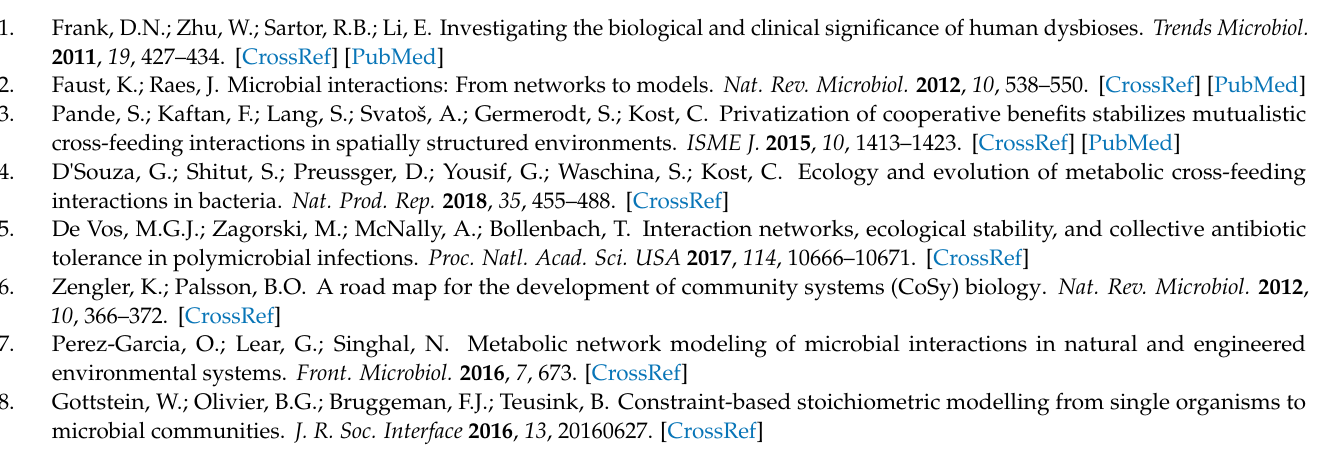
R.: representative. Table S2: Table containing a second selection of genomes for the in silico UTI community. The information was retrieved in July 2021. Genomes were selected in a similar manner with the Supplementary Table S1. Table S3: Complementarity indices. All of them normalized by pathway length. D is the number of KO’s present in the donor d; A is the equivalent for the acceptor a. Table S4: Competition indices. All of them normalized by pathway length. D is the number of KO’s present in the donor d; A is the equivalent for the acceptor a. Competition 1 is only written as the intersection of two sets because stating a division by pathway length is omitted for all cases. Table S5: Possible outcomes of the interactions depending on the value of e. Table S6: Similarly as Table 1 in the main text, but only on Ent as target. Pathways with high complementarity for the pairs with increased growth yield. Top ranking pathways according to the RF feature importance, the SVM coefficients, the MWU p -value, and the ensemble of the previous ranks. Table S7: Repetition of the Table 2, using the new selection of genomes in Table S2. Pathways with high complementarity for the pairs with increased growth yield. Top ranking pathways according to the RF feature importance, the SVM coefficients, the MWU p -value, and the ensemble of the previous ranks.